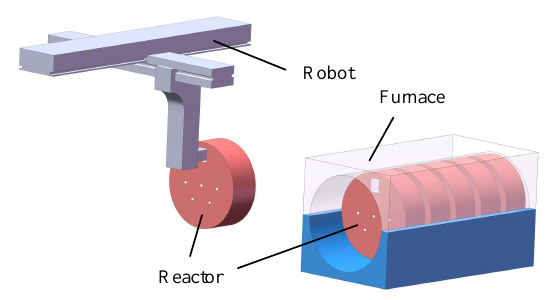
Figure 1. Schematic of a new automatic unloading